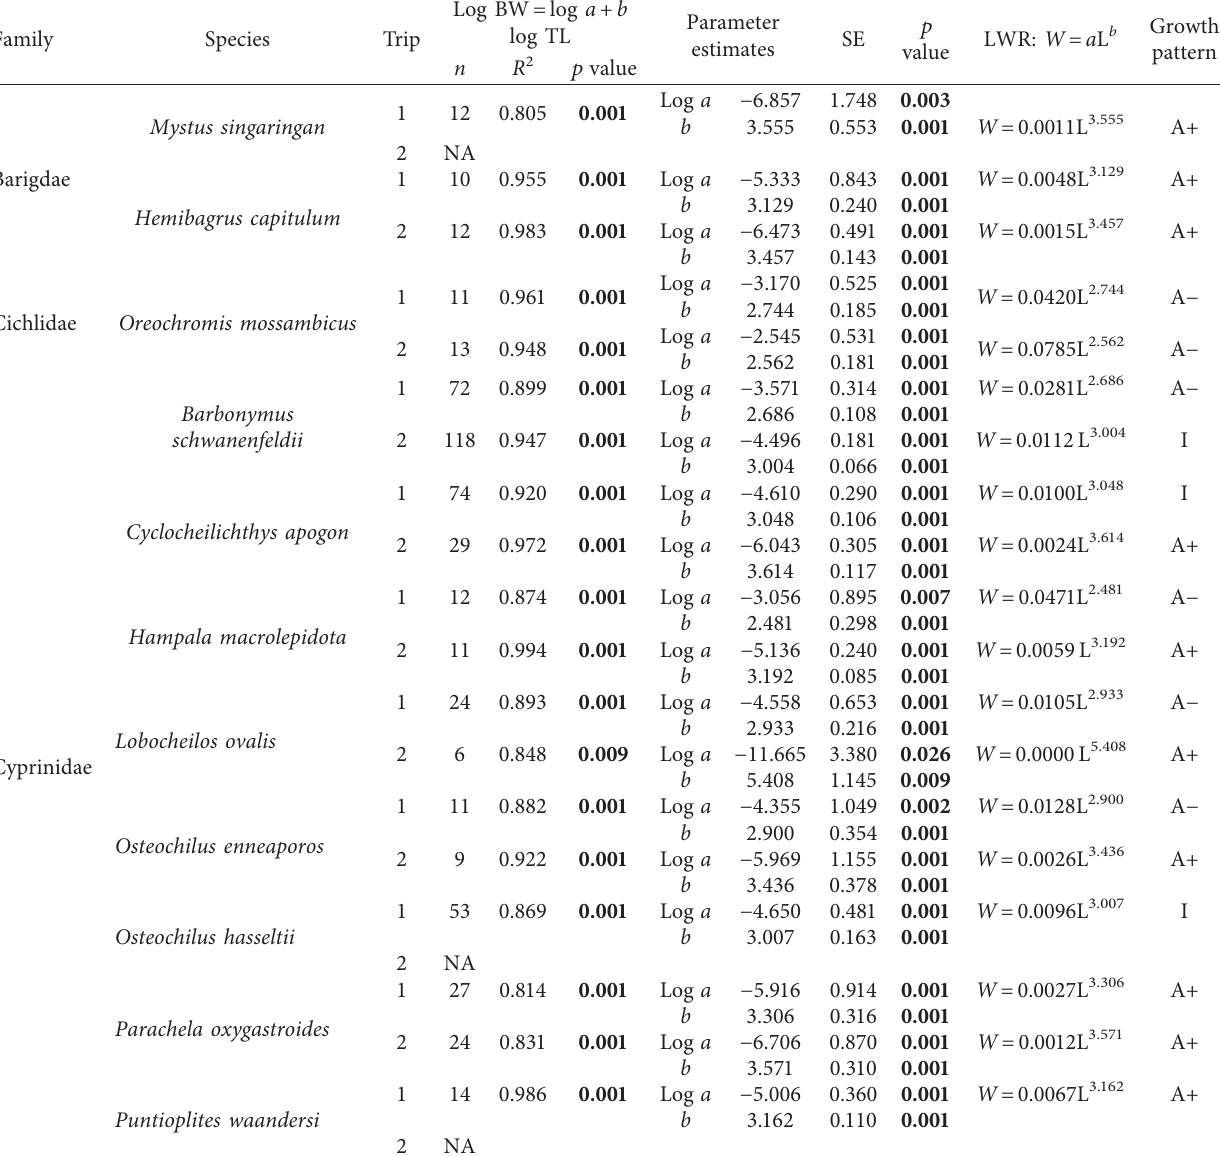
Table 5: Summary of regression analyses of the length-weight relationship (LWR) of selected species in the Murum River during the dry (trip 1) and wet (trip 2)